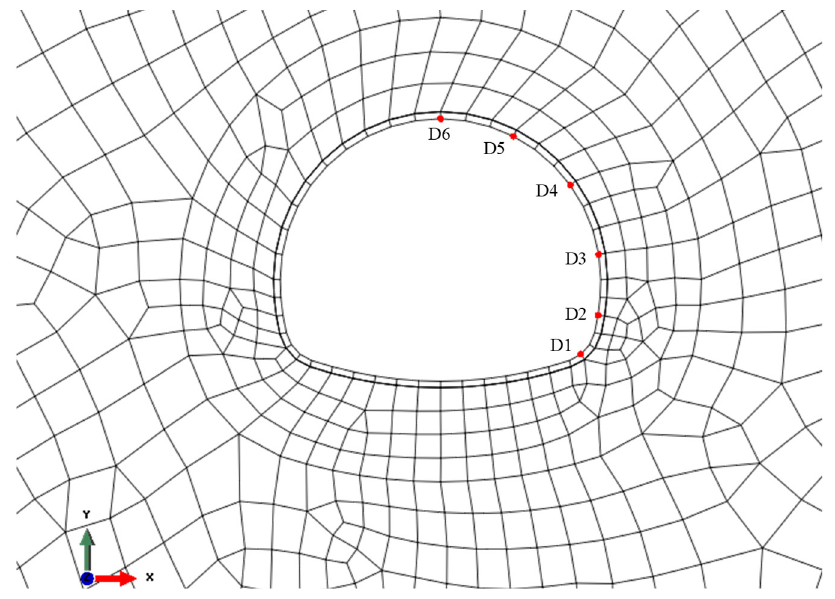
Figure 6. Tunnel model.